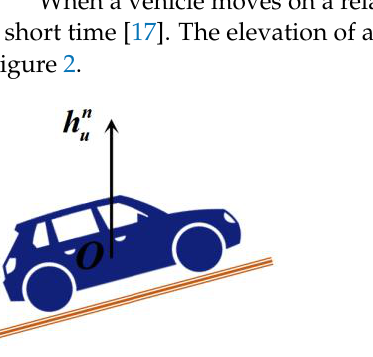
Figure 2. Vehicle elevation in navigation coordinate system.